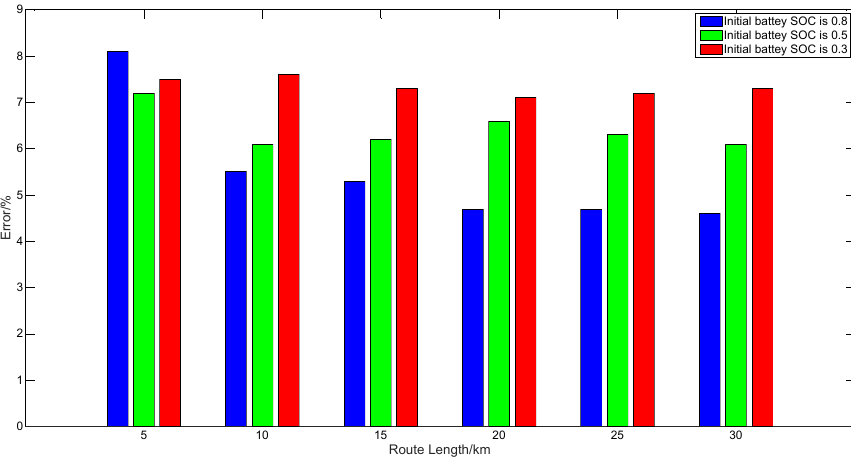
Figure 12. TEEM performance compared with the real routes